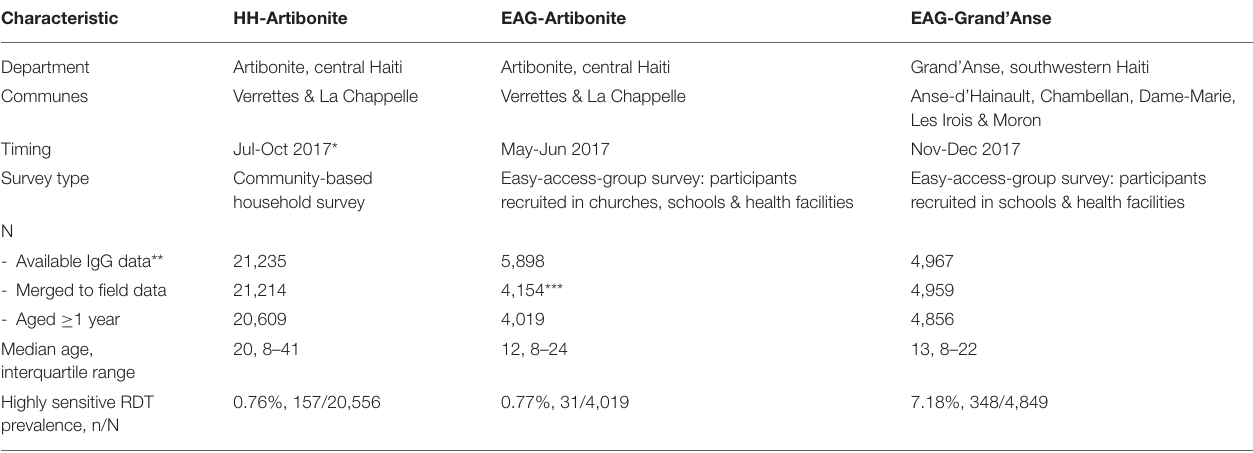
TABLE 1 | General characteristics of the study population for three malaria cross-sectional surveys performed in Haiti.